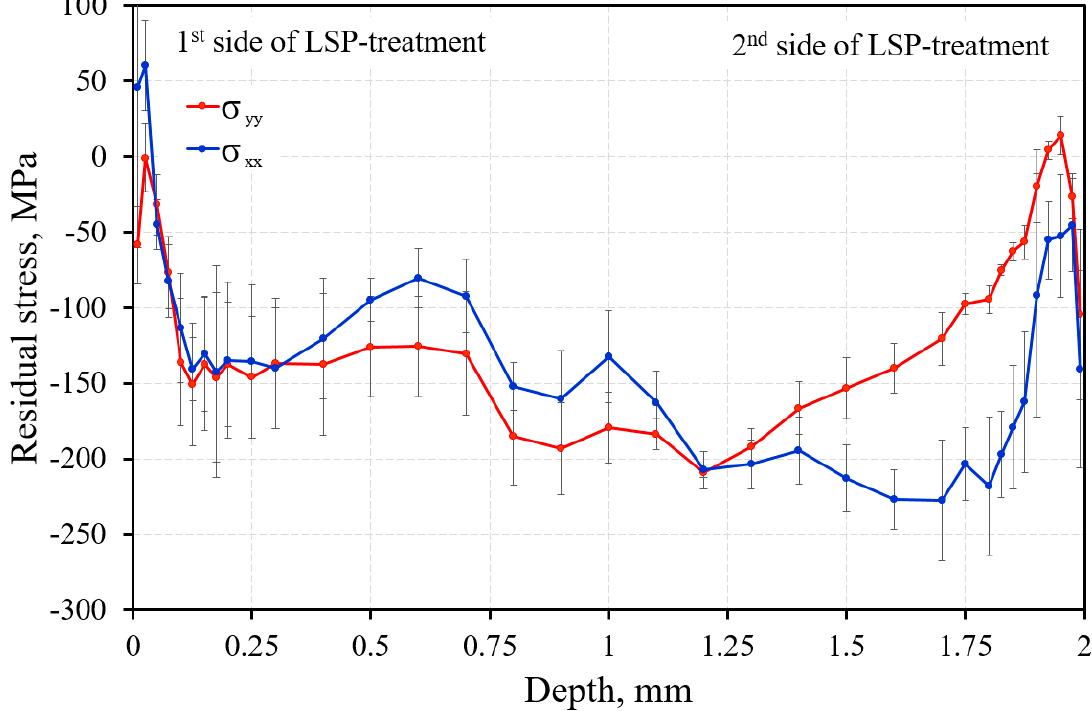
Figure 7. Depth resolved residual stress profile in LSP ‐ treated specimen, as shown in Figure 6.